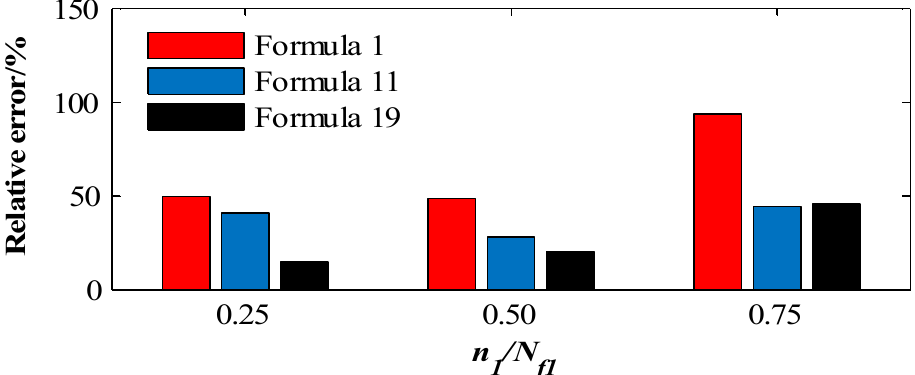
Figure 11. (331.5–284.4 MPa) The relative error of each model under different n 1 /N f 1 (45# steel).